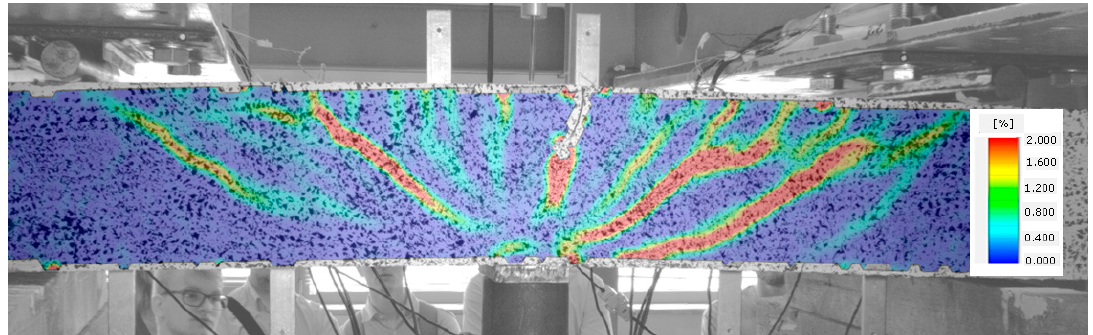
Figure 14. Stage V of shear behavior of element—shear tension failure of the beam.